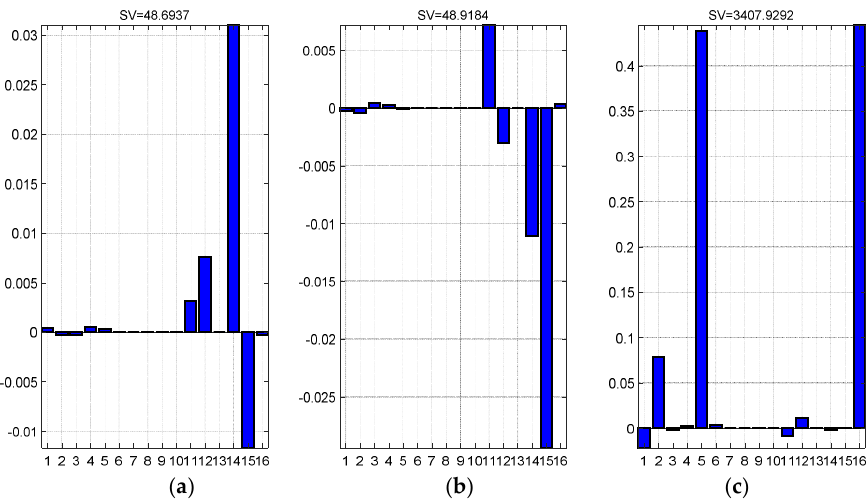
Figure 5. Observability analysis results of state variables. ( a ) Description of the ∆ θ observability; ( b ) Description of the ∆ γ observability; and, ( c ) Description of the ∆ ψ